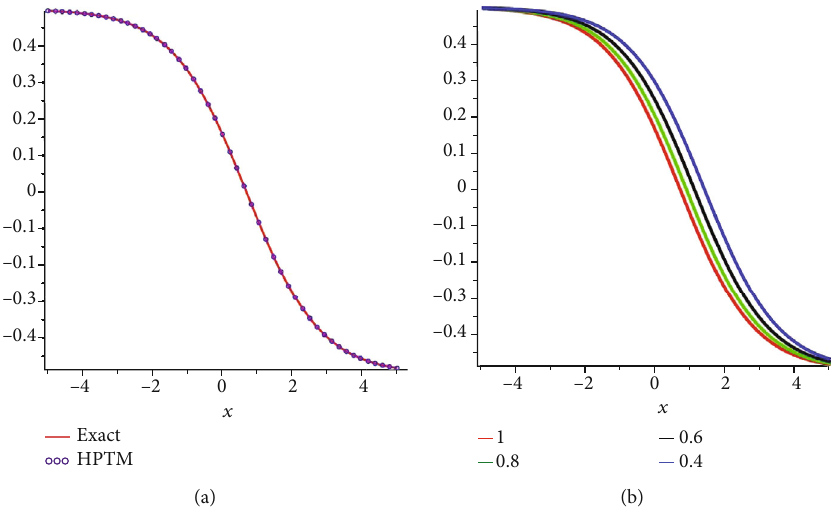
Figure 4: (a) The fi rst fi gure of actual and analytic result and (b) and the second fi gure of various fractional order of β of Case 3.